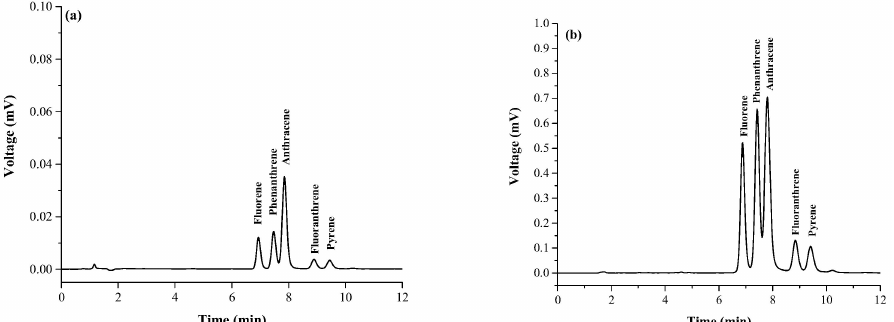
Figure 6. Chromatogram comparing analyses of ( a) a mixture standard of polycyclic aromatic hydrocarbons with direct injection by HPLC and ( b ) a mixture of standard of polycyclic aromatic hydrocarbons after magnetic stirring assisted demulsified dispersive liquid–liquid microextraction technique: concentration of all standards was 100 ng · mL − 1